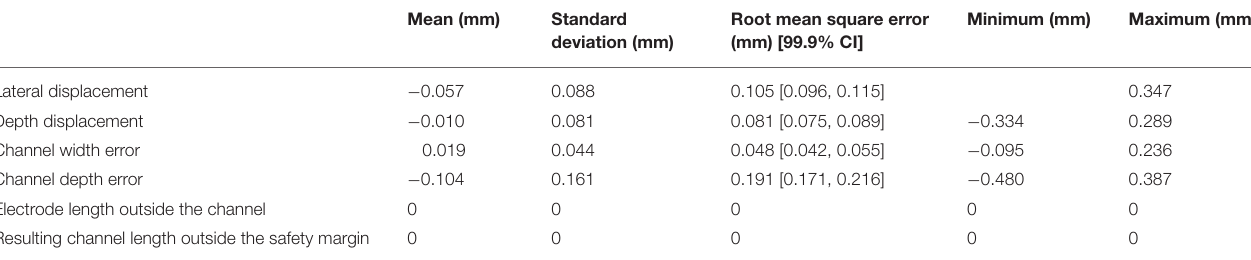
TABLE 1 | Summary of the measured endpoints.